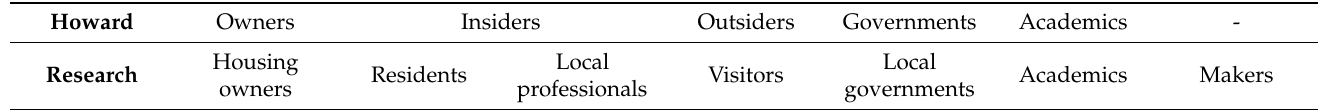
Table 2. Stakeholder groups as defined by Howard as heritage markets applied in this